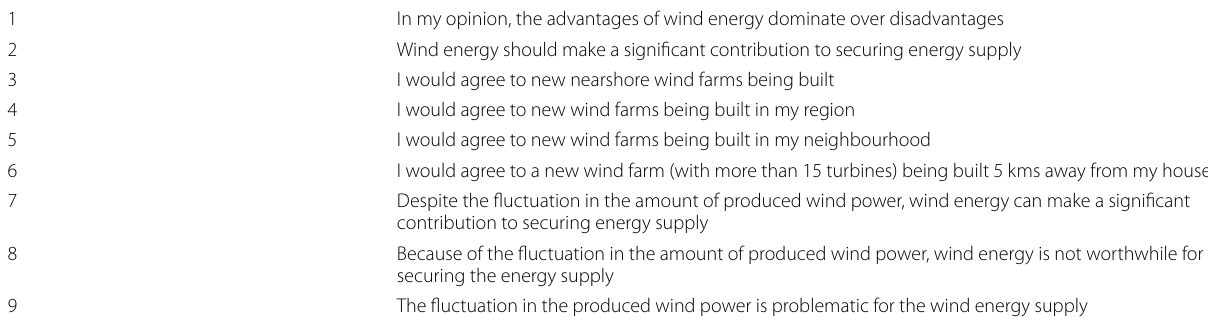
Item 8 and item 9 were later inverted for the further statistical analyses. Cronbach’s α material used in data collection